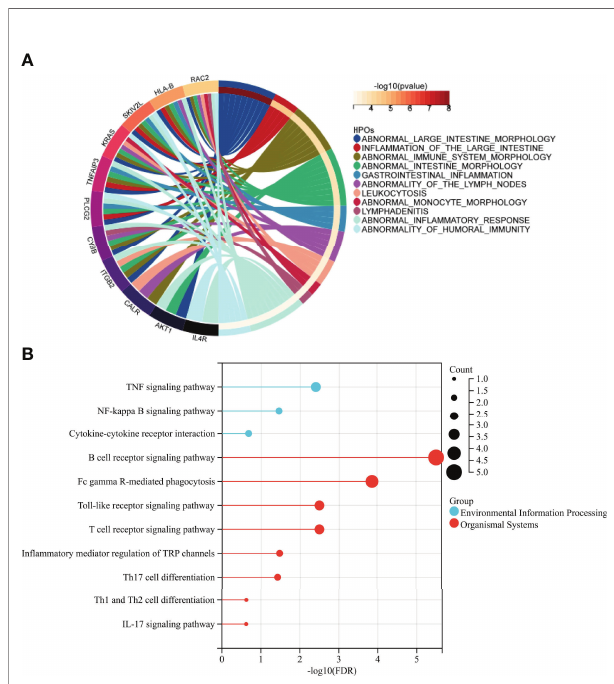
FIGURE 8 | Identi fi cation of the immune function of SIRGs (A) HPO enrichment analysis showed that 28 SIRGs were associated with abnormal intestinal immunity. (B) The immune related KEGG pathway of